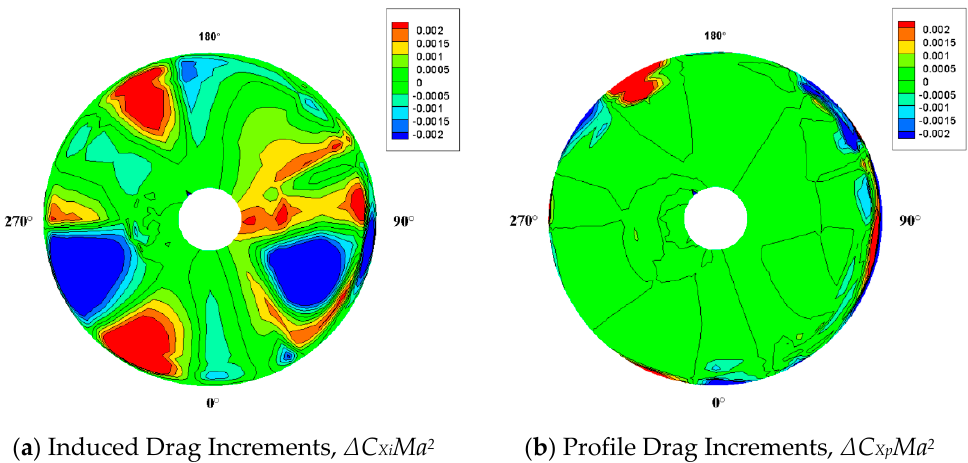
Figure 26. Dimensionless drag load increment distributions of the 3-seg control relative to the 2-seg control for condition B.